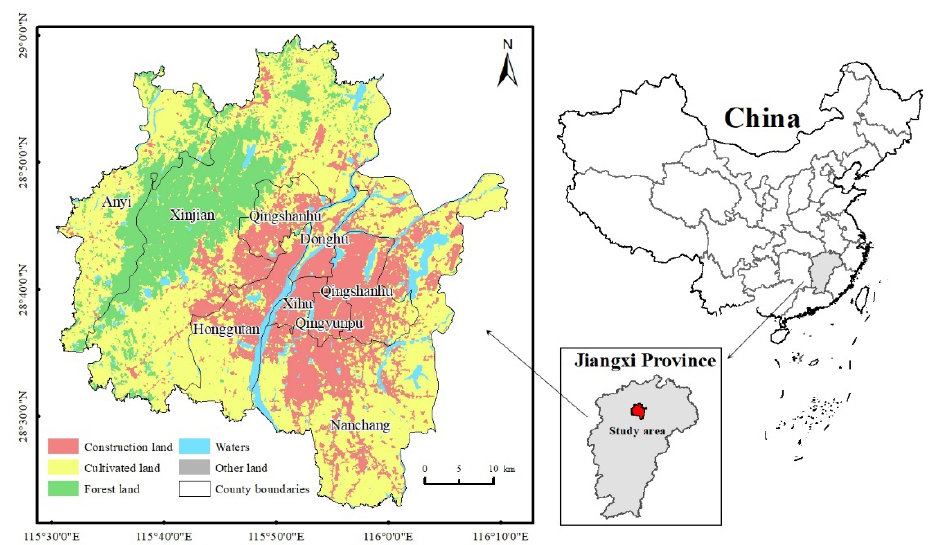
Figure 2. Location of the study area and land use of the Nanchang Metropolitan Area in 2018.